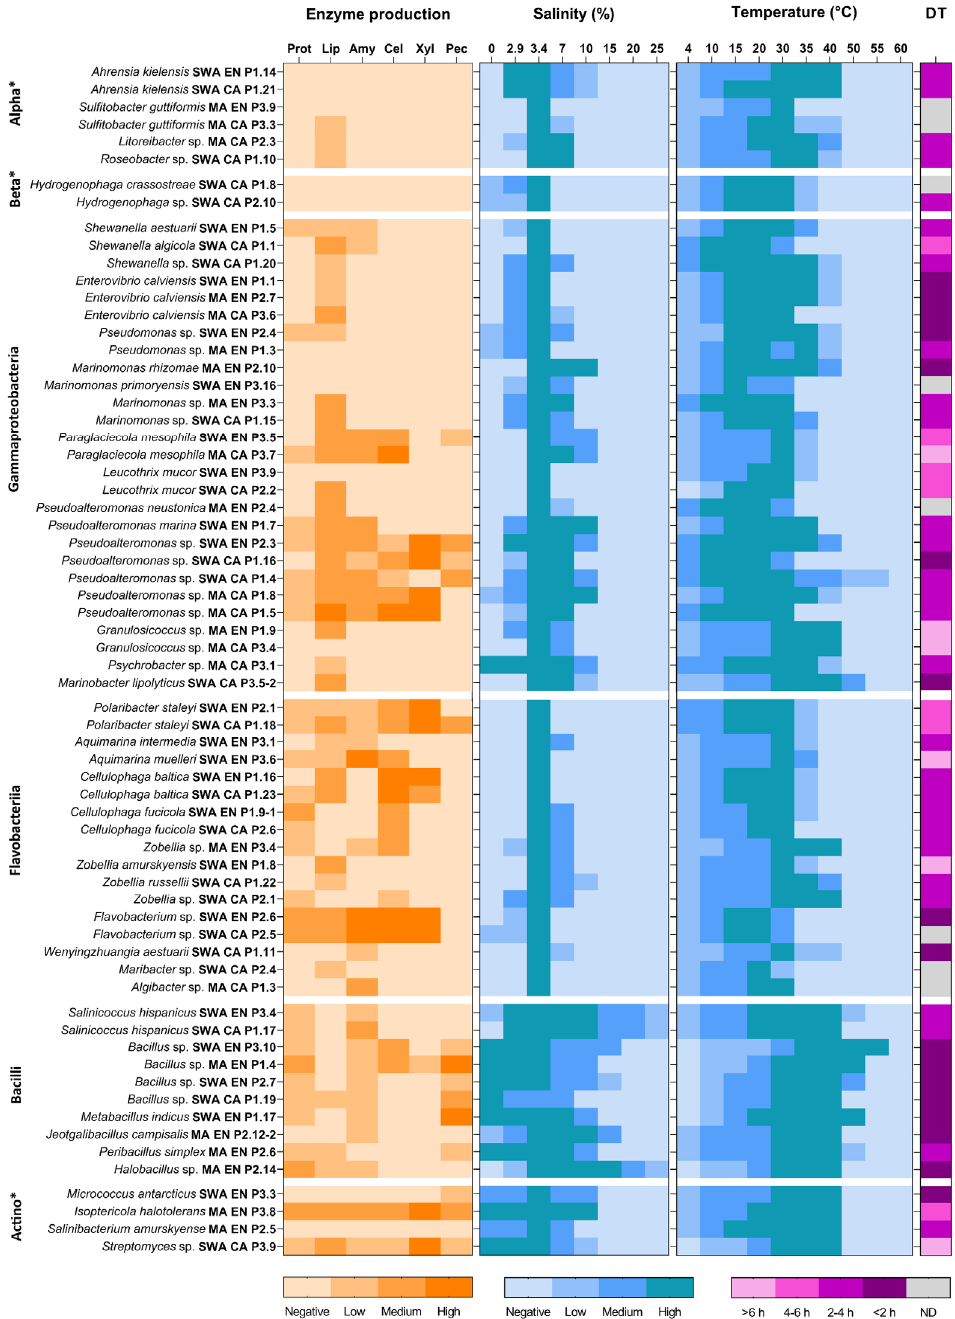
Figure 5. Heat maps of hydrolytic enzyme production and growth characteristics of the isolated bacterial strains. The levels of enzyme activity, salinity (% NaCl, w / v ) and temperature ( ◦ C) intervals, and doubling time (DT) were determined as indicated in Methods. Alphaproteobacteria (*Alpha), Betaproteobacteria (*Beta), Actinobacteria (*Actino); not determined